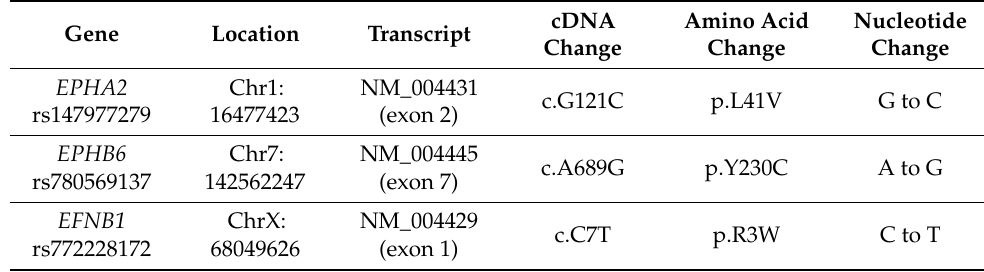
Table 2. Position and changes induced by the 3 gene